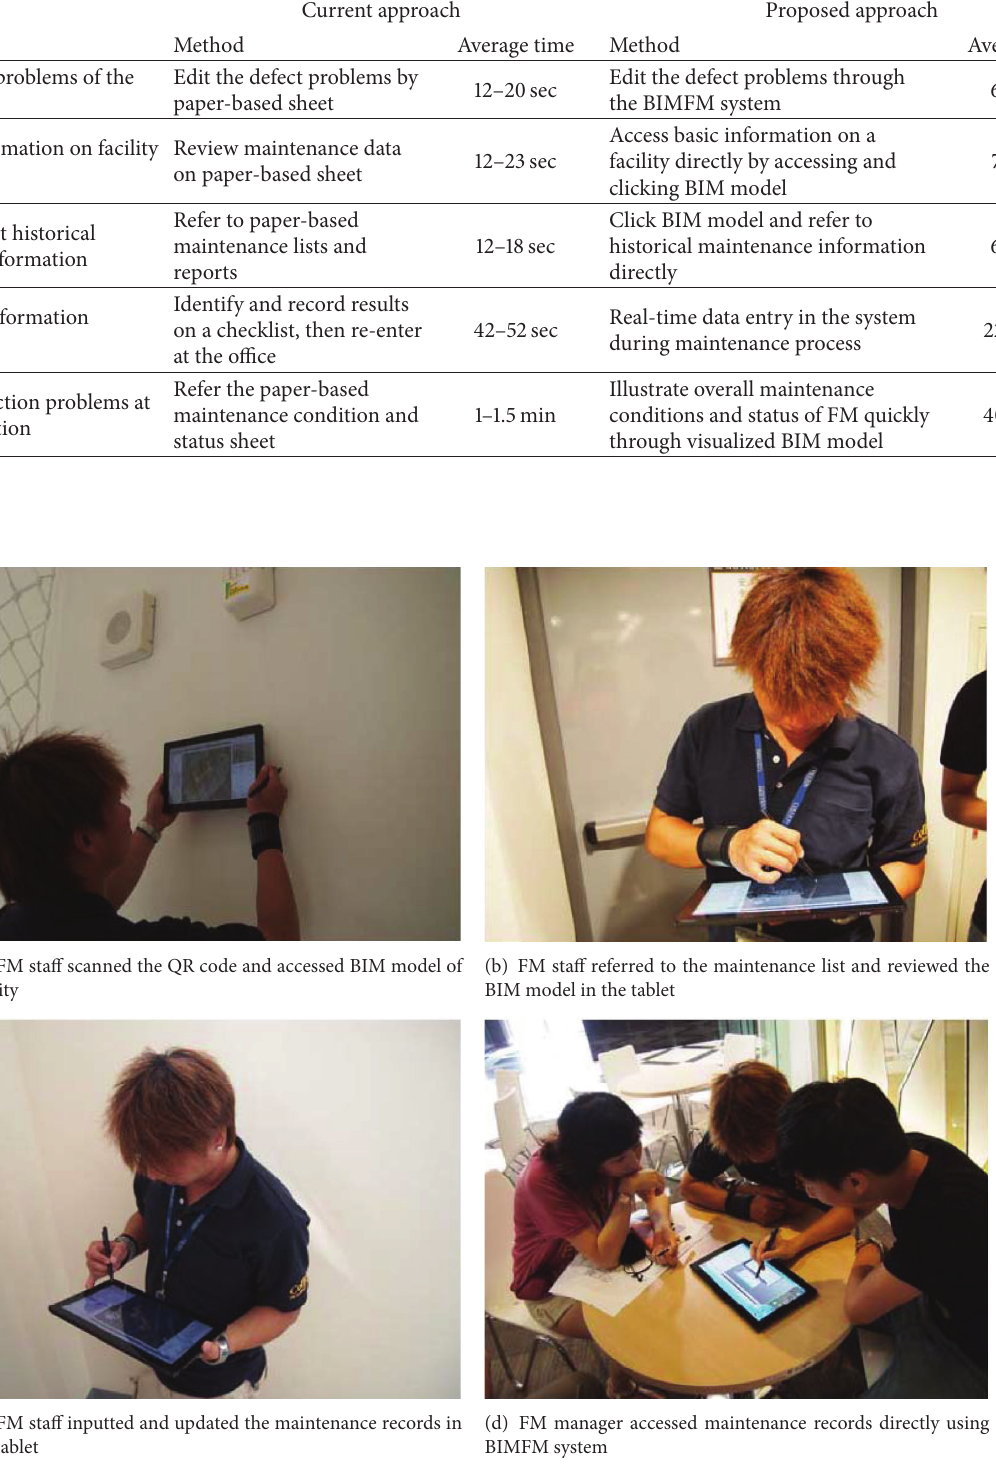
Figure 6: FM staff using webcam-enabled tablet to scan QR code label for FM work in the case